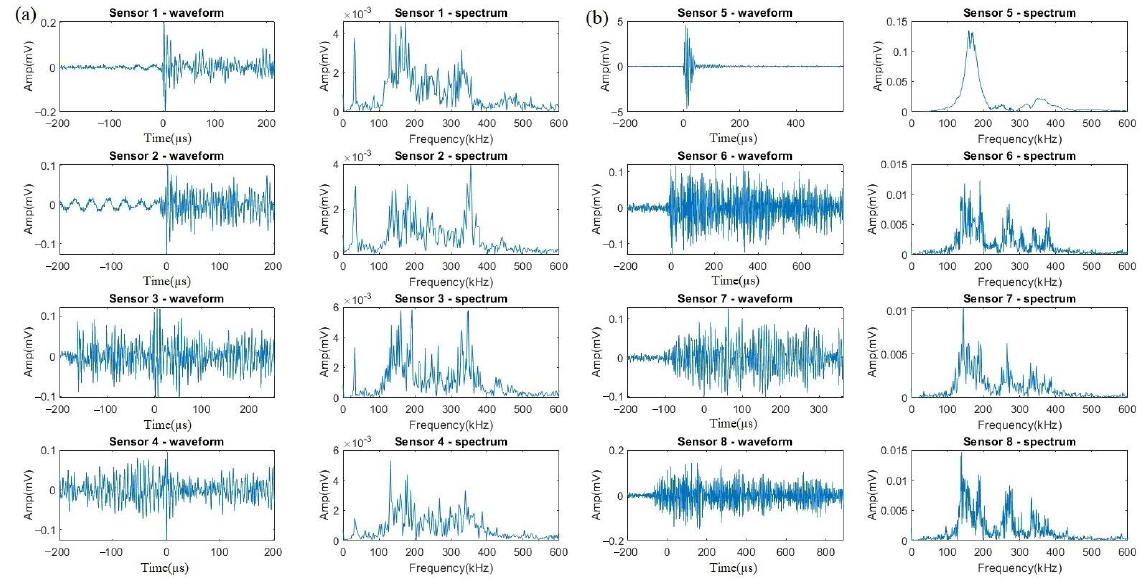
Figure 8. The waveforms and spectrums from the same event of crevice corrosion acquired by ( a ) Nano30 sensors and ( b ) VS150-RIC sensors